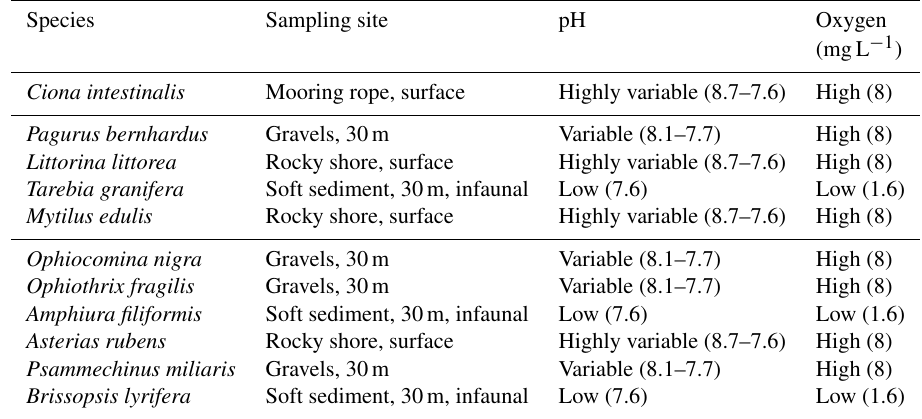
Table 1. Species used in the experiment, along with the habitat where they were collected and the characteristic pH and O 2 levels in these habitats. Values of pH and O 2 at the habitats are taken from Dorey et al. (2013), Hu et al. (2014) and Grans et al.